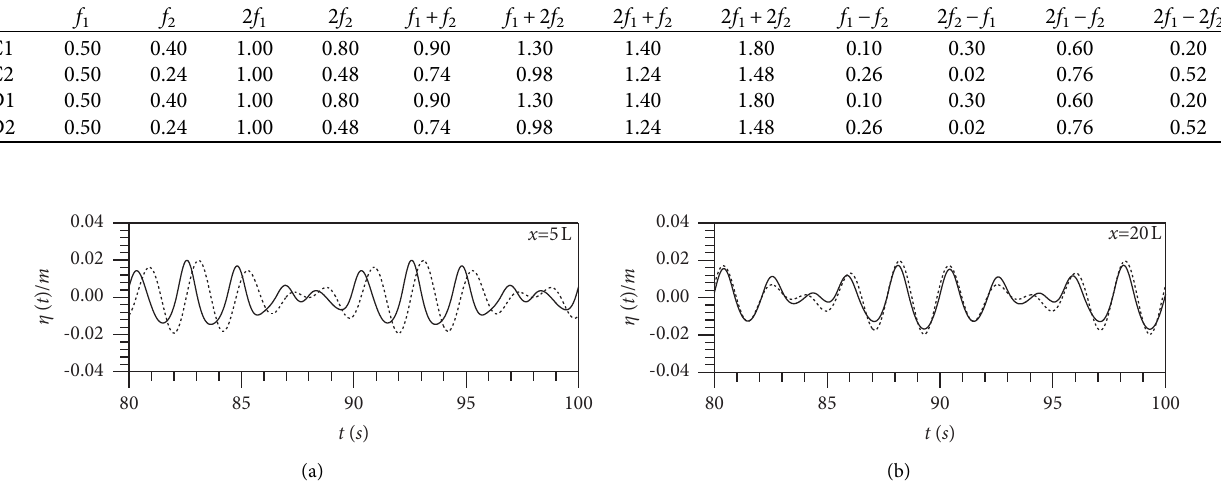
Table 2: Table of main components of frequency spectrum analysis for different cases (HZ).